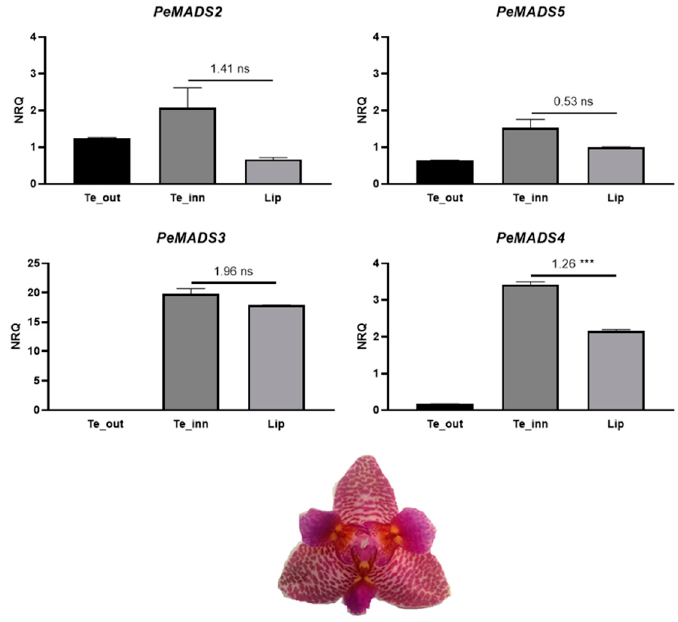
Figure 8. Relative expression of the class B MADS-box genes PeMADS2–5 in the perianth of Phalaenopsis hyb. “Joy Fairy Tale” at the B2 developmental stage (bud size 1–1.5 cm). The expression is reported as normalized relative quantity (NRQ). The vertical bars represent the SEM of the biological and technical replicates. The numbers above the horizontal lines are the mean differences of the expression between lateral inner tepals and labellum-like structures (Te_inn-Lip). p -Values *** <0.001; ns, not significant. Te_out, outer tepals; Te_inn, labellum-like structures that substitute the lateral inner tepals in the peloric mutant. Note the different scale for PeMADS3